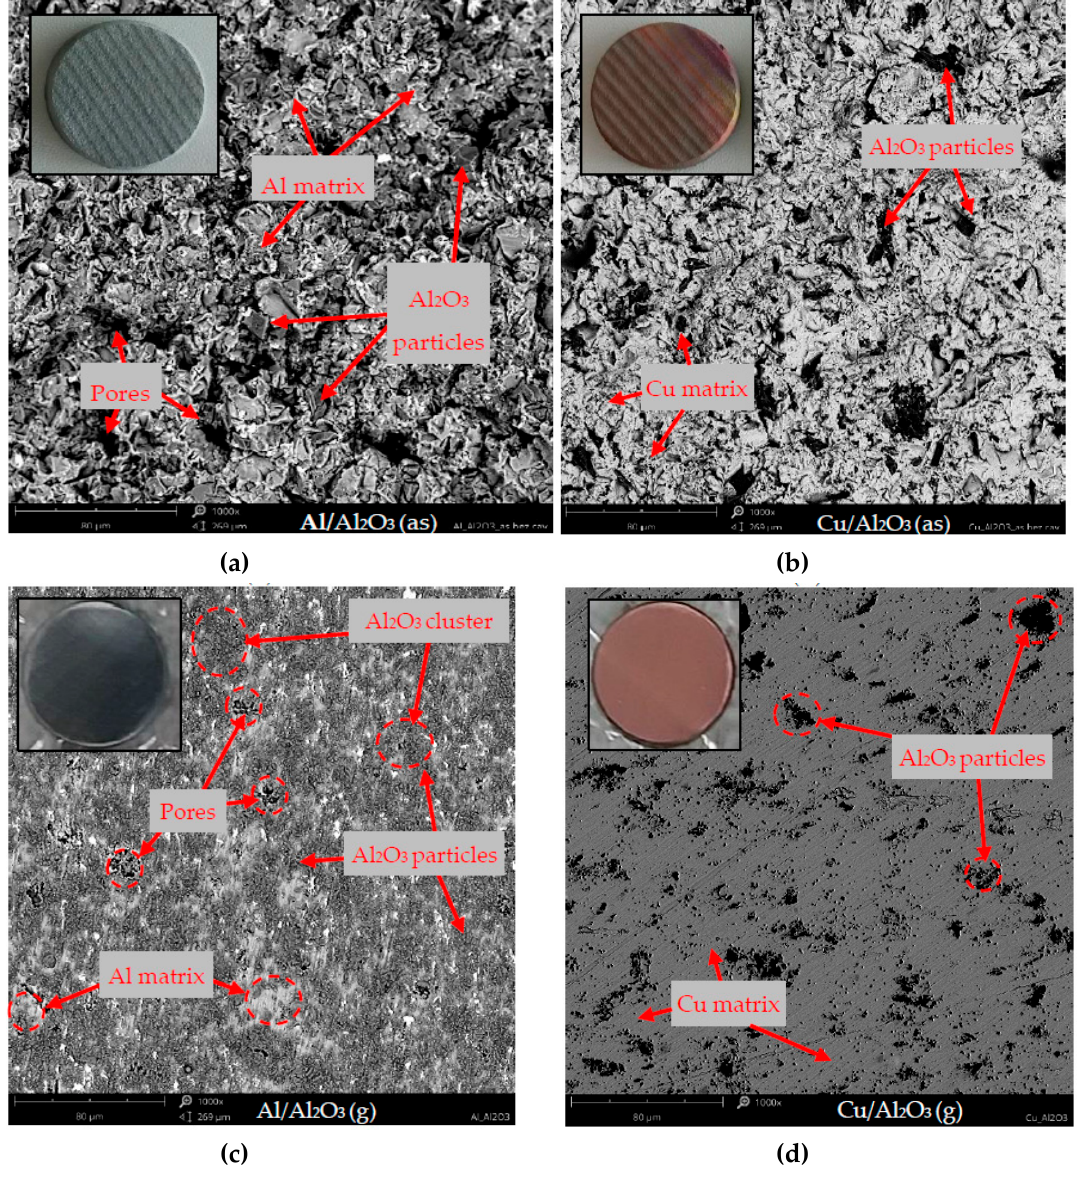
Figure 2. Surface morphology of composites: ( a ) As-sprayed Al/Al 2 O 3 ; ( b ) as-sprayed Cu/Al 2 O 3 ( c ) ground Al/Al 2 O 3 and ( d ) ground Cu/Al 2 O 3 , macrophoto and SEM-BSE.